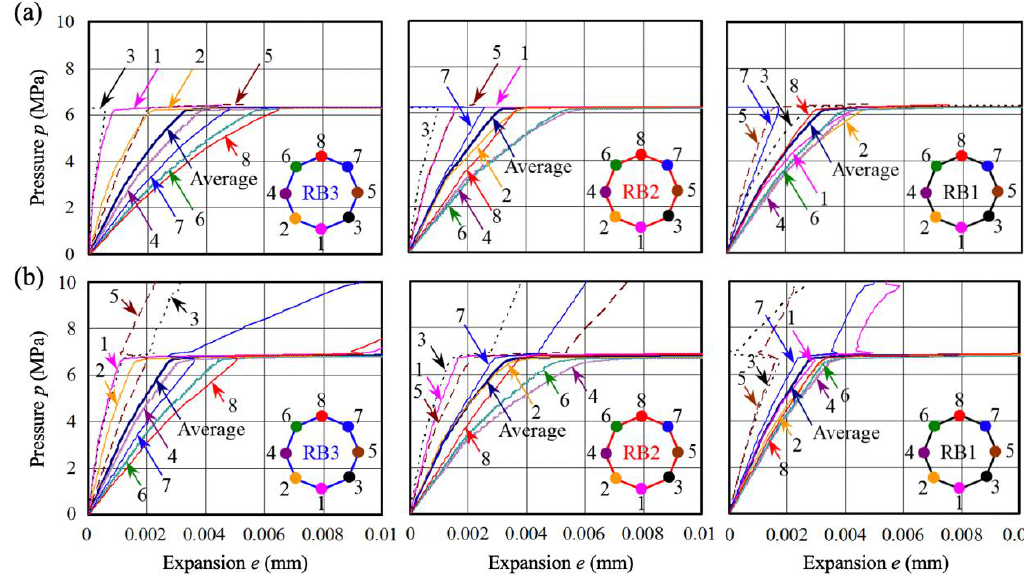
Figure 14. Relationship between internal pressure and expansion according to the expansion direction of longitudinal bars: ( a ) L-A0, without lateral confinement; ( b ) L-A4, with large lateral confinement.